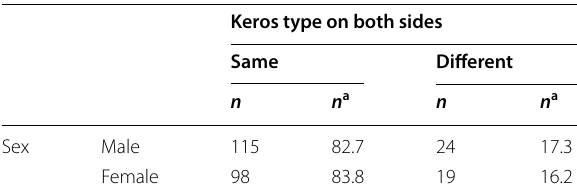
Table 3 Distribution of Keros type on both sides according